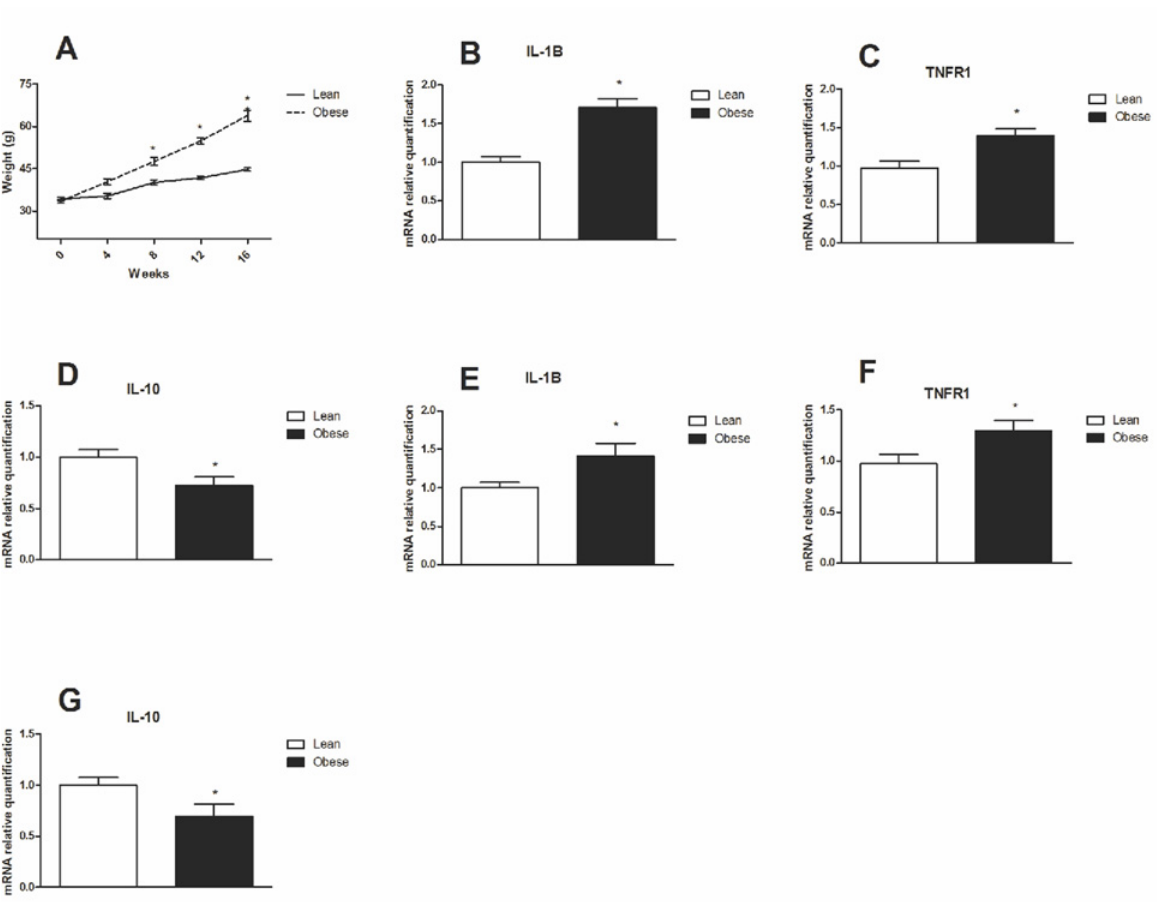
Fig 1. Weight gain and inflammatory markers in hypothalamus of obese mice. A. Weight gain of mice fed a high fat diet compared to chow for 16 weeks. QRT-PCR was used to analyze the gene expression of B. IL1- β , C. TNFR1 and D. IL-10 in the hypothalamus of DIO mice at 8 weeks of treatment. QRT-PCR was used to analyze the gene expression of E. IL1- β , F. TNFR1 and G. IL-10 in the hypothalamus of DIO mice at 16 weeks of treatment. Values are shown as mean ± SEM. * P < 0.05; n = 6 animals per